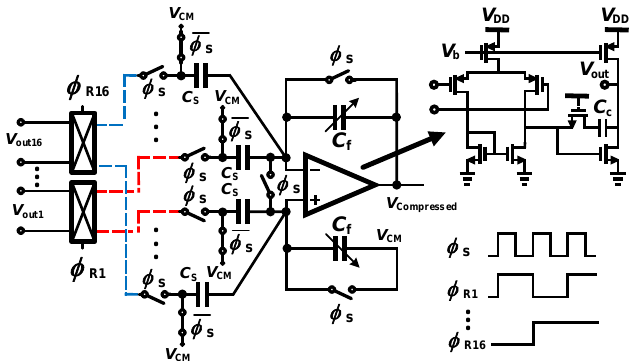
Figure 23. Schematic of the proposed multiple-input single-output compressive sensing block,